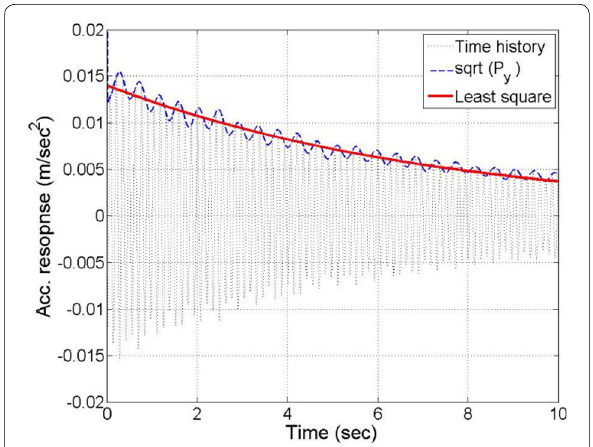
Fig. 8 The covariance of the third mode response and its estimation.